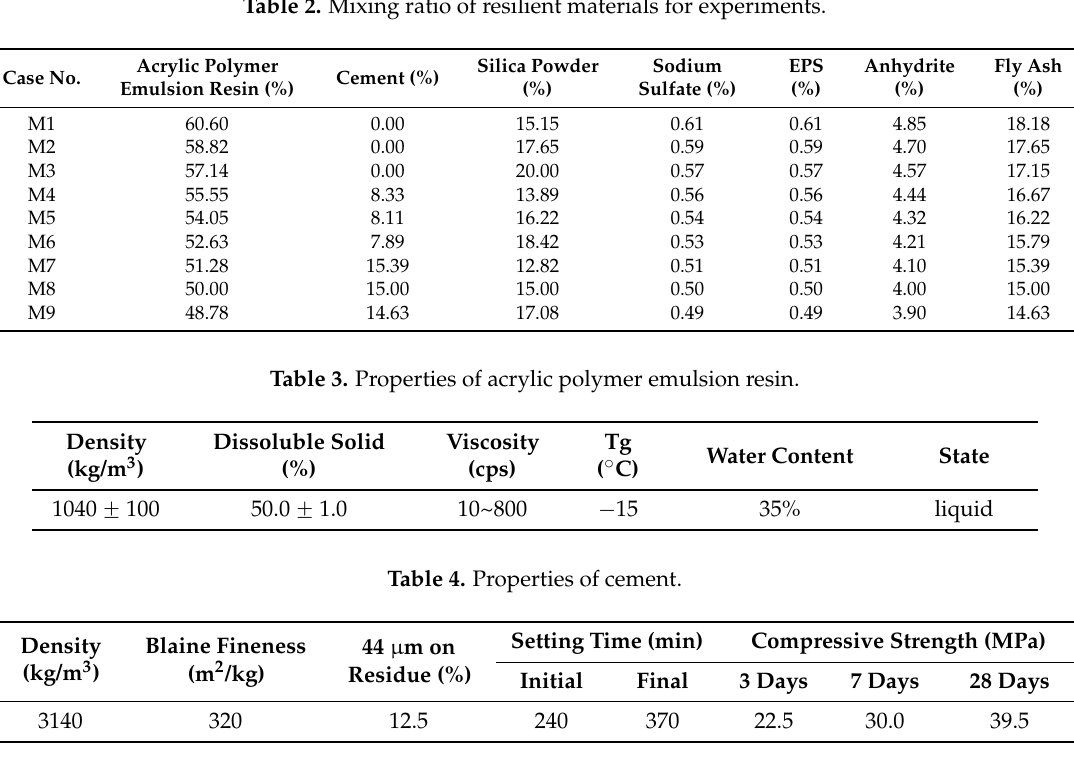
Table 2. Mixing ratio of resilient materials for experiments.